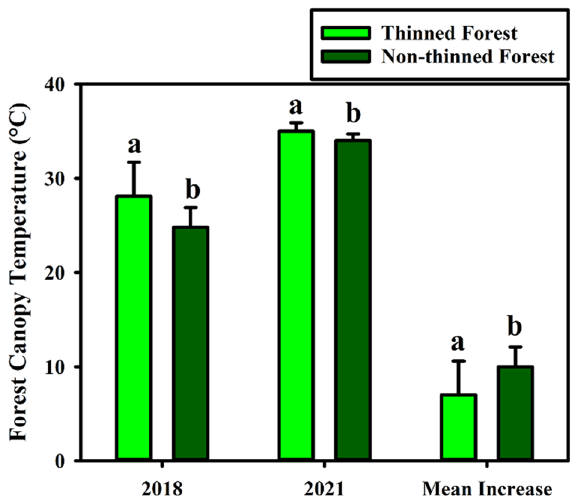
Figure 4. UAV thermal image-derived mean canopy temperature in thinned (N = 10,000 randomly-selected pixels) and non-thinned (N = 10,000 randomly-selected pixels) ponderosa pine forests during average precipitation year 2018 and drought year 2021. The different letters within pairs of bars (a versus b) indicate a statistically significant difference (p < 0.01). Thinned forest canopy temperature is consistently and significantly (p < 0.001) greater when compared to non-thinned forest canopy temperature using an ANOVA test. However, mean canopy temperature increase from average precipitation year 2018 to drought year 2021 is significantly (p < 0.001) greater for the non-thinned forest compared to the thinned forest.